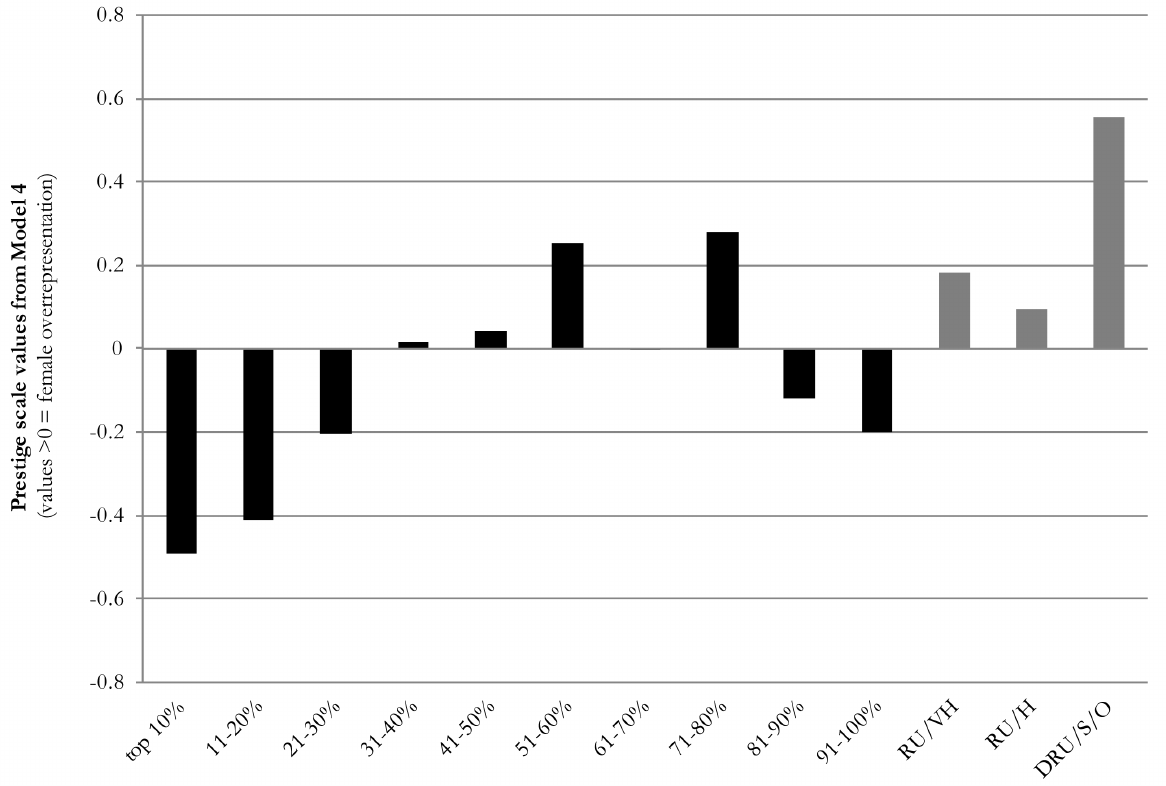
Figure 2: Pattern of relative prestige segregation among U.S. doctorates, 2003–2014. Notes: Lighter shaded bars are unranked programs. Data source: IPEDs